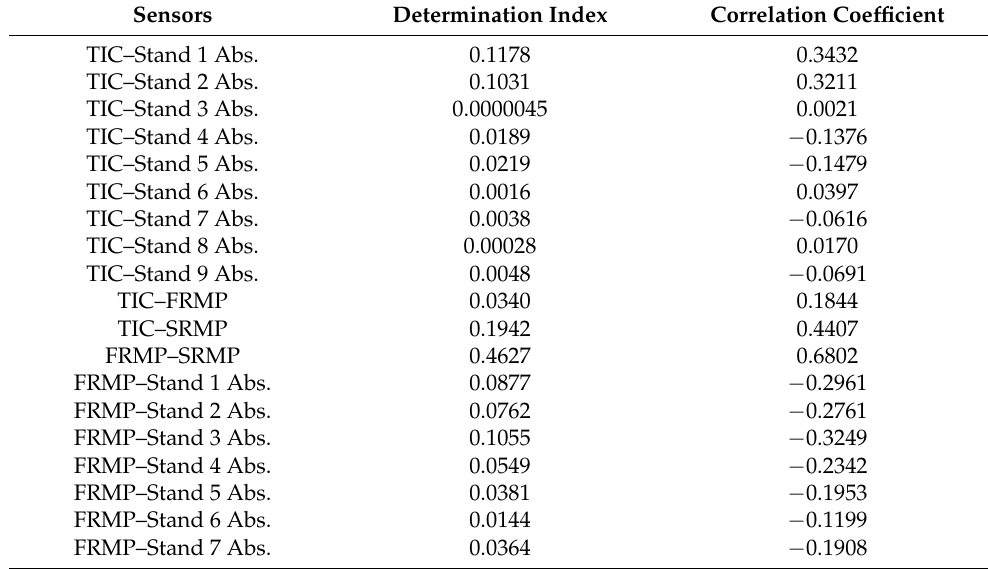
Data analysis results ( original plant configuration) for the billets with the same production